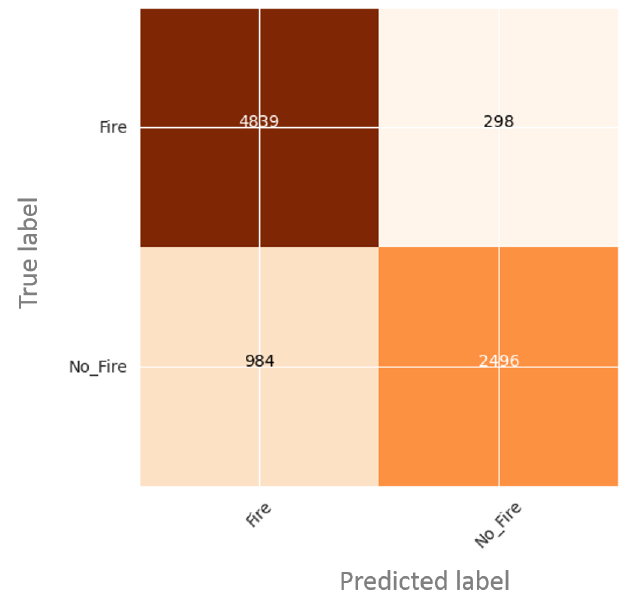
Figure 7. Confusion matrix for fire